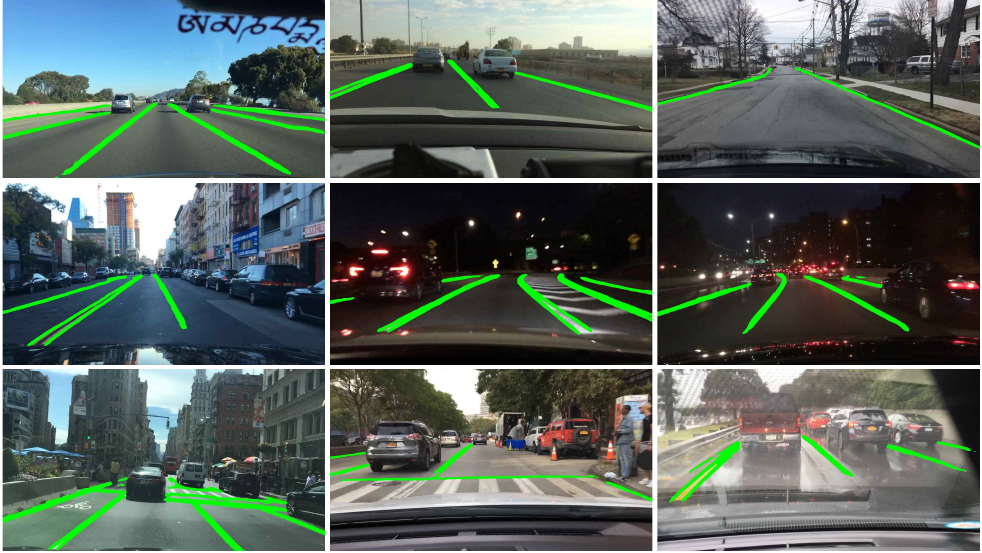
Figure 5. Visualization of lane line segmentation